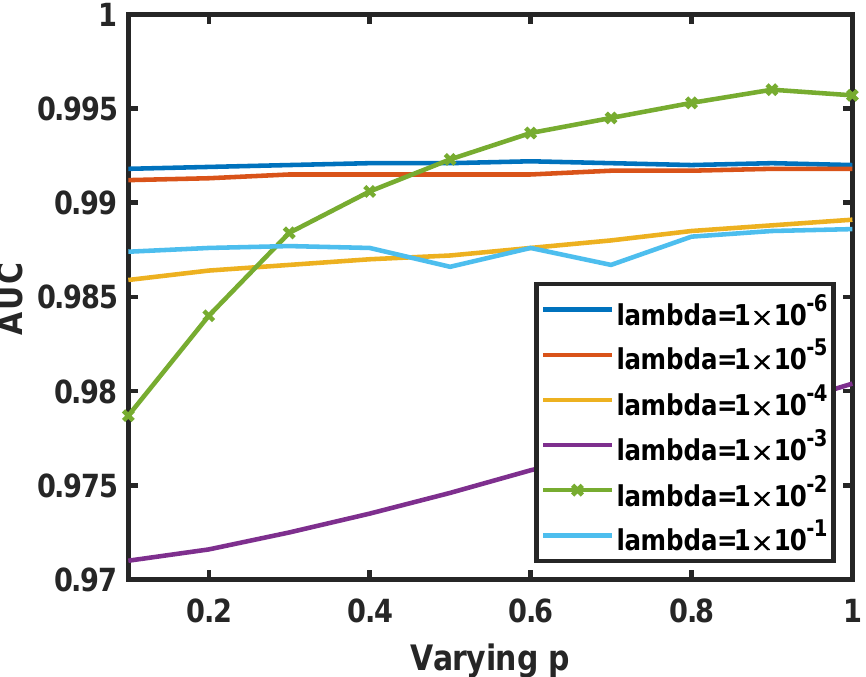
Figure 8. Area under curve (AUC) values of different varying p , as well as lambda ( λ ), in the Gulfport dataset.